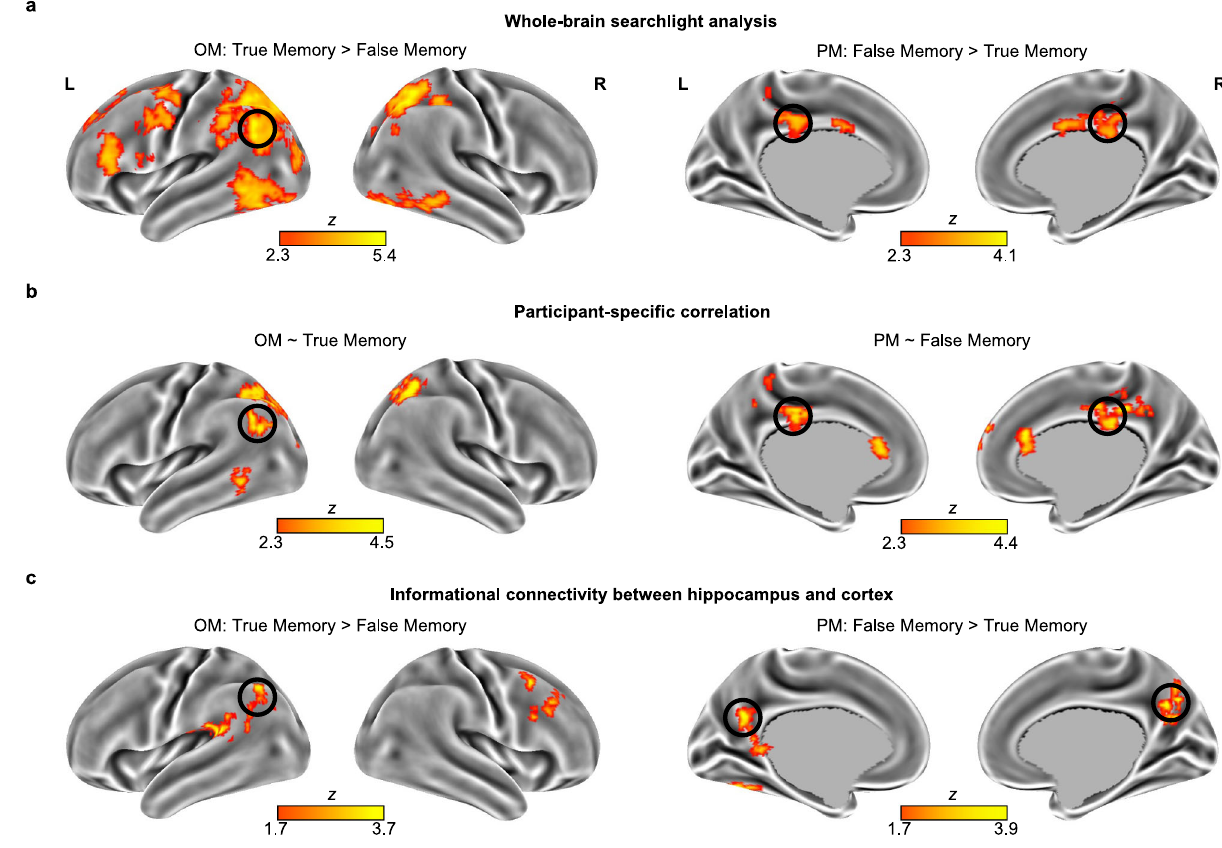
Fig. 6 | Cortical representations of true and false memories and their con- nectivity with the hippocampus. a Multiple brain regions (e.g., the left angular gyrus)showed greateritem-speci fi crepresentationsof originalinformationduring the memory test (OM) for true memory than false memory, but only the posterior cingulate gyrus showed greater item-speci fi c representations of post-event infor- mation during the memory test (PM) for false memory than true memory. b Participant-speci fi cneural-behavioralcorrelation.Thelateralparietalcortex(e.g., the left angular gyrus) carried participant-speci fi c original information that